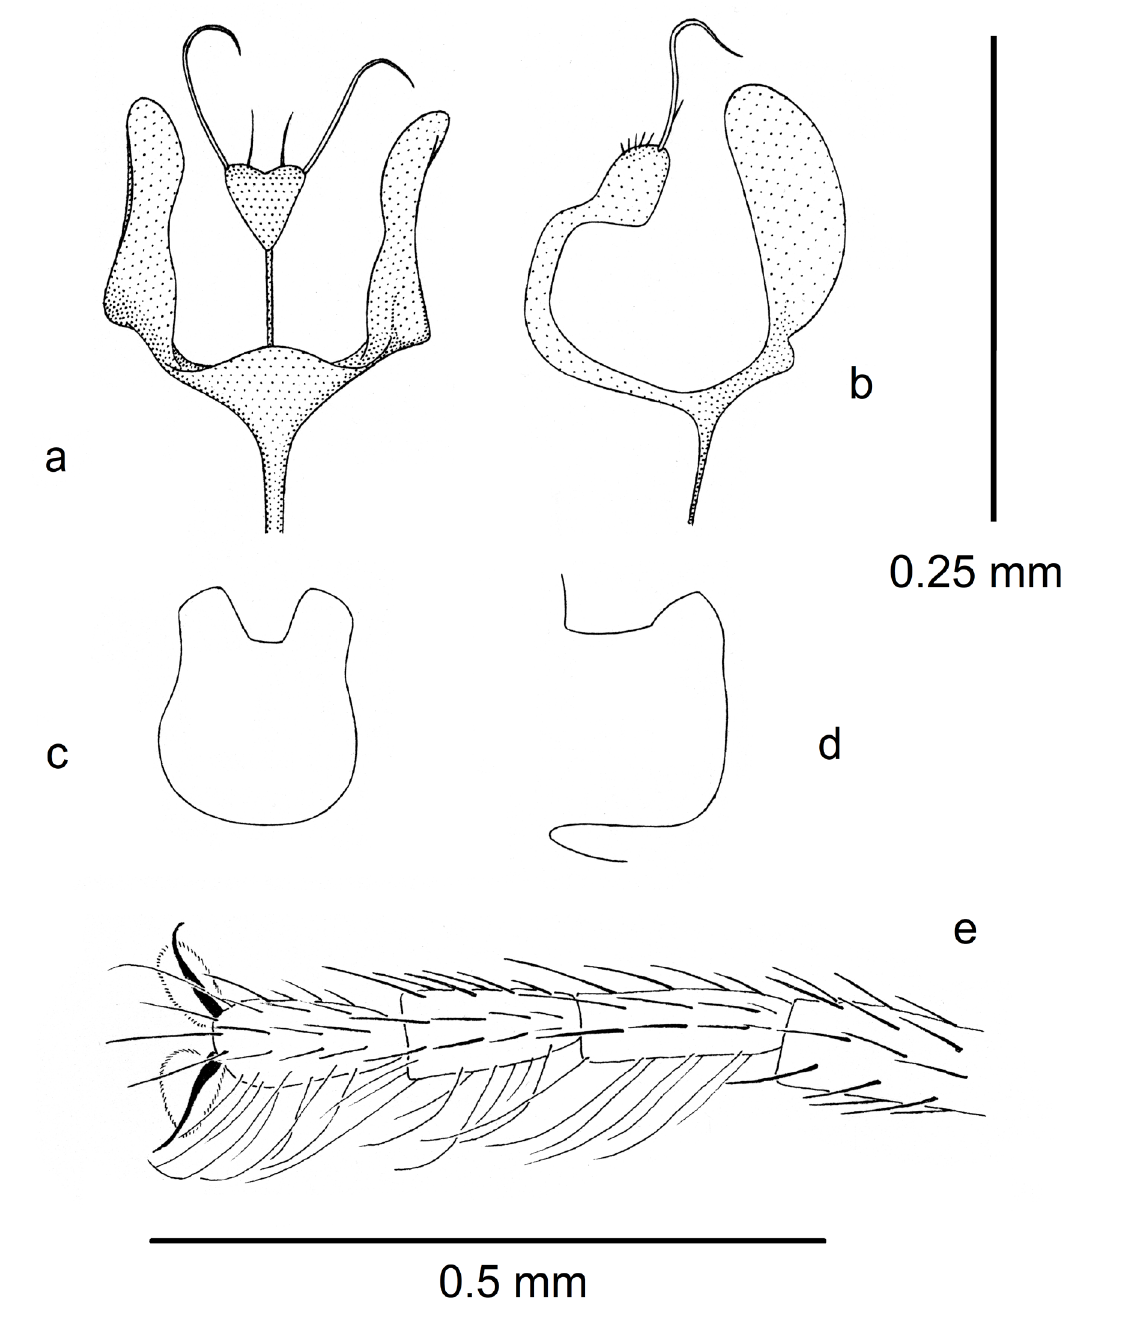
Fig. 4. Atherigona zongoi sp. nov., holotype, ♂ (NMWC). a . Trifoliate process, ventral. b . Same, lateral. c . Hypopygial prominence, posterior. d . Same, lateral. e . Fore